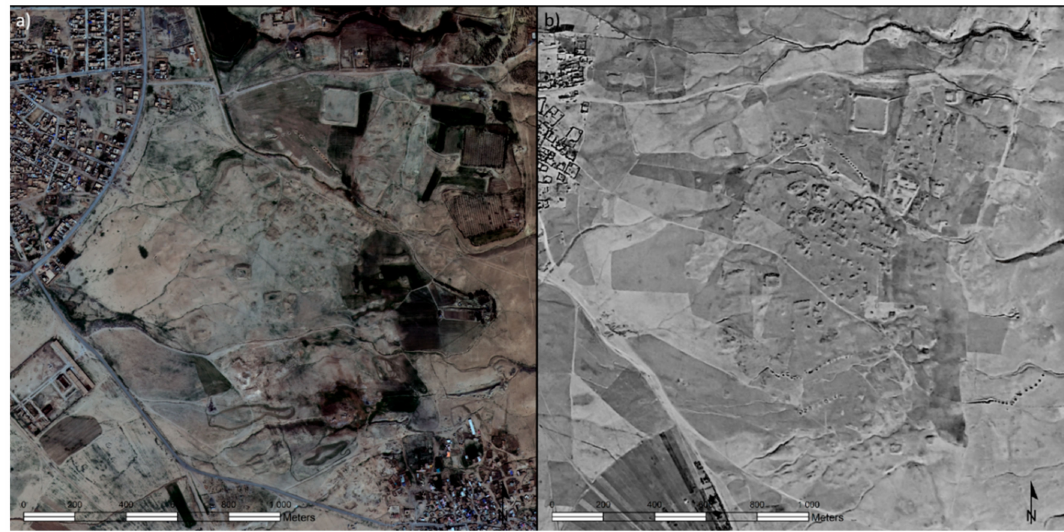
Figure 9. Monitoring of the gradual recession of relics: ( a ) Image from 2013, WorldView-2—the dynamics of the transformation process of the site show the hard destruction of features, especially in the central part of the site (WorldView-2 © Digital Globe Inc., distribution e-GEOS / ARCDATA PRAHA s.r.o.); ( b ) historical image from the Hexagon mission 1971—most of the parts that are above ground are still preserved and detectable (author: Lenka Starkov á ).